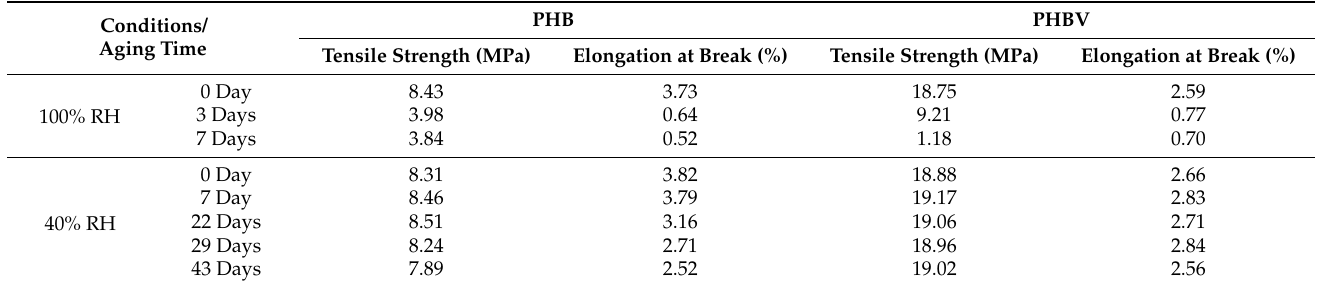
Table 2. Mechanical properties of PHB and PHBV samples over 43 days in 100% RH and 40% RH soil conditions.